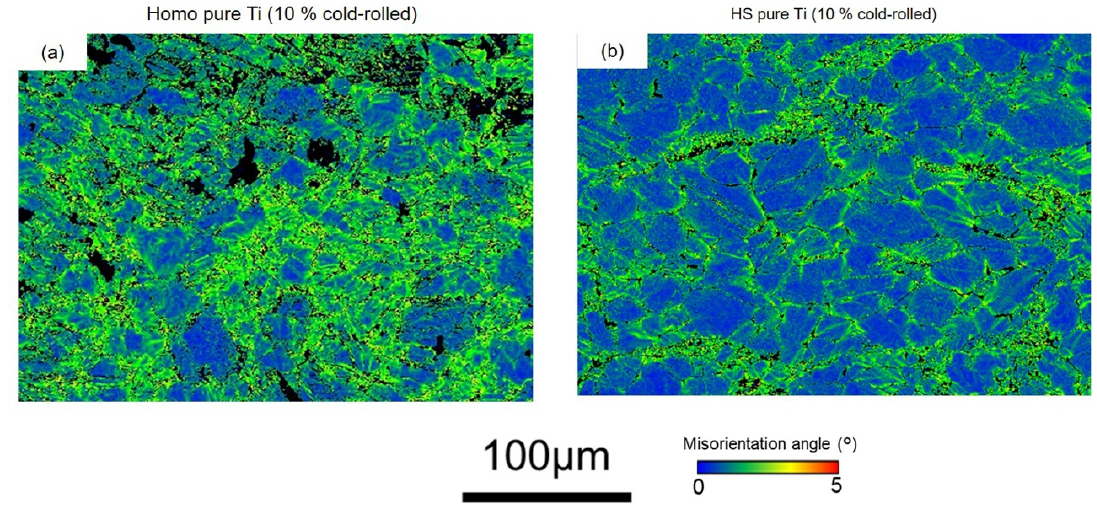
Figure 9. KAM image of; ( a ) homo and ( b ) HS structured pure Ti compacts.